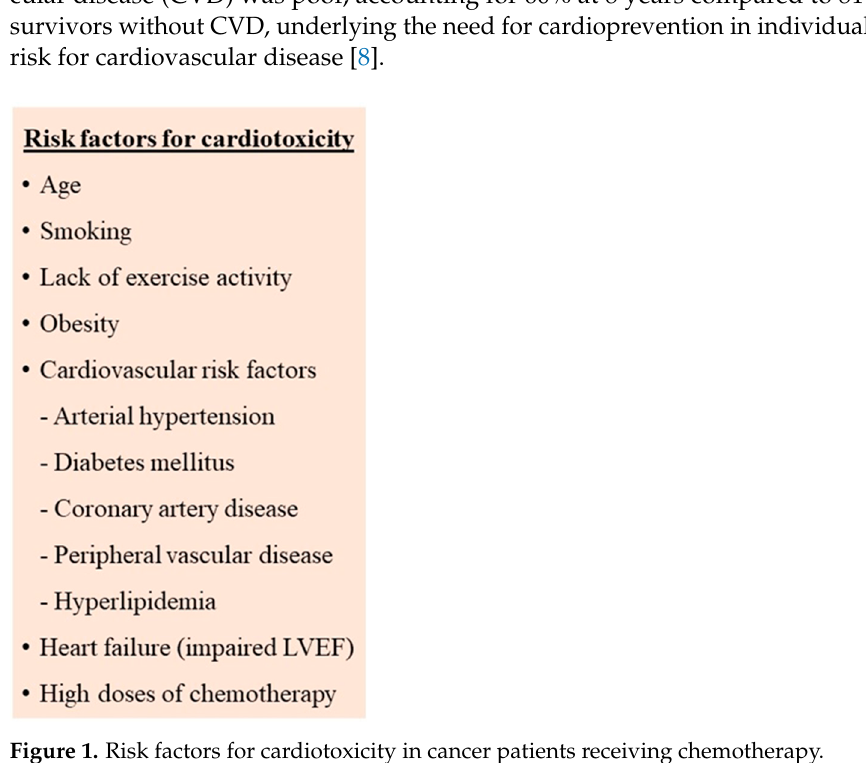
Figure 1. Risk factors for cardiotoxicity in cancer patients receiving chemotherapy.